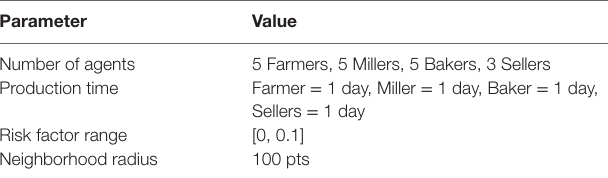
TaBle 7 | initial conditions for experiment #5.